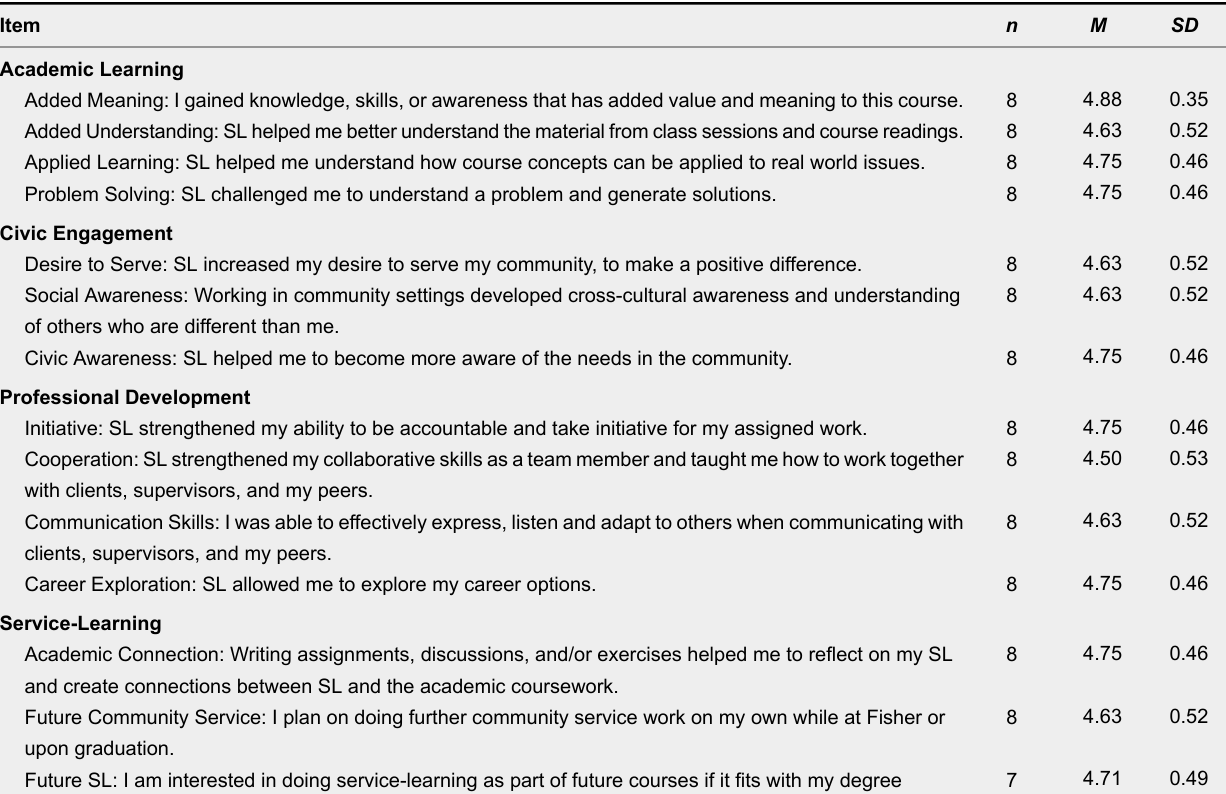
Means and Standard Deviations of Civic Engagement Student Impact